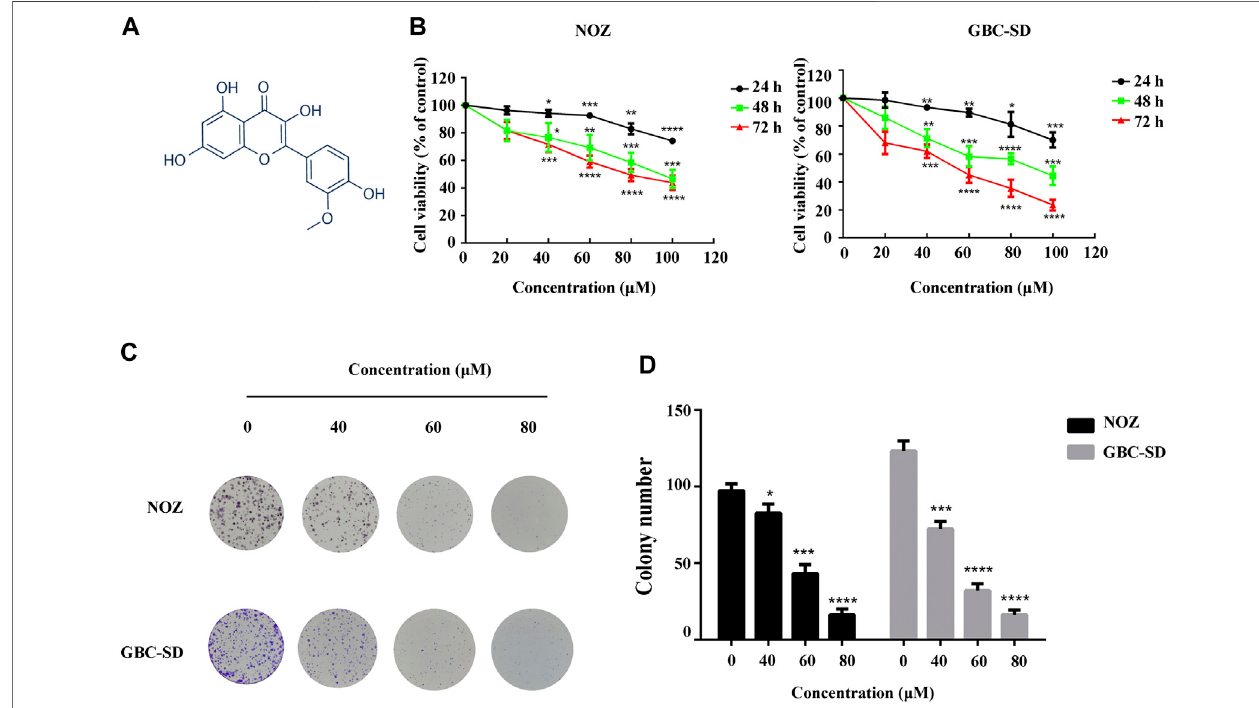
FIGURE1| IsorhamnetinsuppressesGBCcellproliferation invitro . (A) Chemicalstructureofisorhamnetin. (B) ThecellviabilityofGBCcellsassessedusingCCK-8 assay after isorhamnetin treatment (0, 40, 60, 80, and 100 μ M) for 24, 48, and 72 h. (C) Colony formation assay of NOZ and GBC-SD cells exposed to isorhamnetin (0, 40, 60, , and 80 μ M) for 10 days. (D) The colony numbers ( > 100 cells/colony) were calculated manually. * p < 0.05, *** p < 0.001, **** p < 0.0001 relative to the control group.